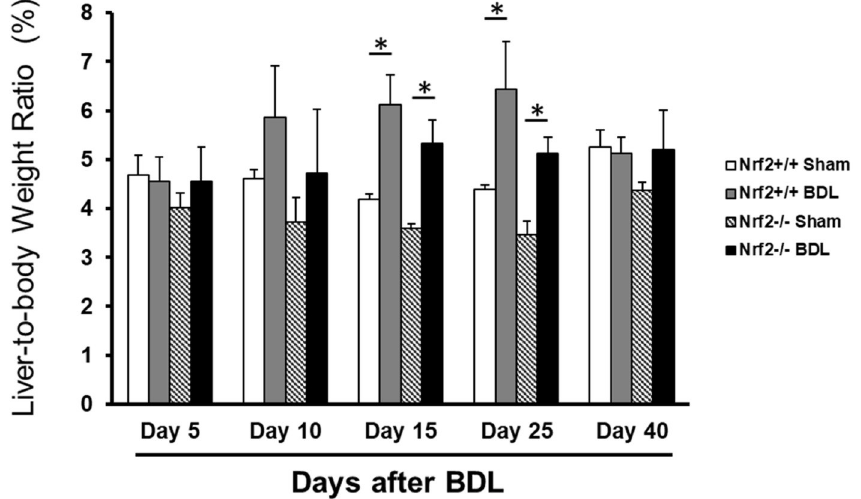
Fig 1. Liver-to-body weight ratios in Nrf2 +/+ and Nrf2 -/- mice after bile duct ligation (BDL) or sham operation (Sham). Adult male mice of both genotypes were subjected to BDL or Sham operation. Mice were sacrificed at the time points indicated. Data are presented as mean liver-to-body weight ratio ± SD (n = 5). � P < 0.05.